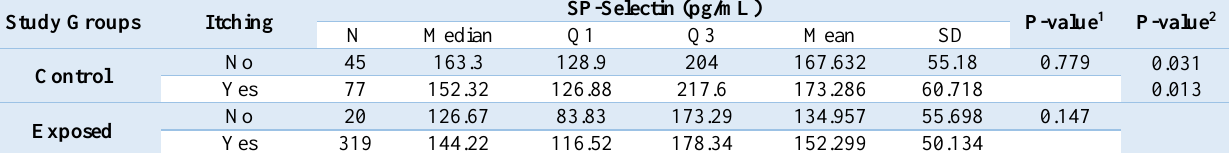
Table 7. sP-Selectin in the Control and Sulfur Mustard Exposed Groups With Itching Study